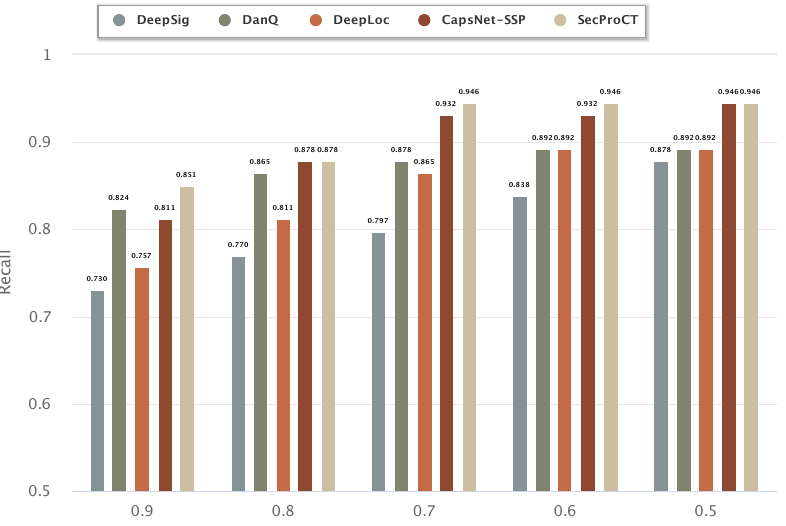
Figure 4. Prediction results of known cancer markers in